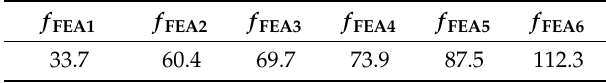
Table 2. Natural frequencies of the initial FE model. FEA—finite element analysis.